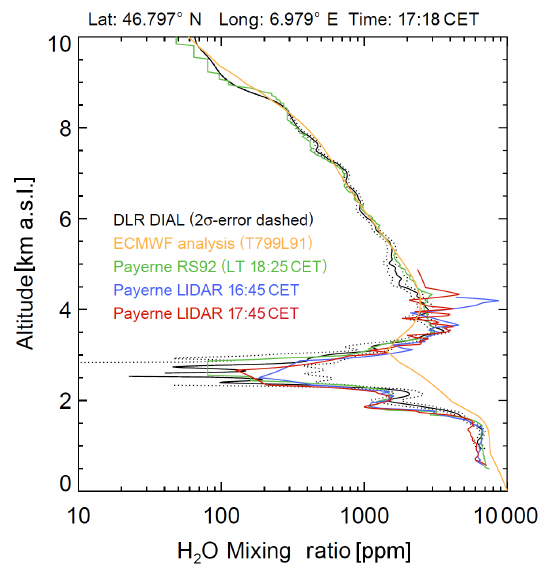
Figure A1. Comparison of the water-vapour mixing ratio from the Raman and the airborne lidar, and from a sonde ascent at Payerne; in addition, the corresponding humidity result from an ECMWF anal- ysis is given, which barely shows the intrusion layer. The times for the lidar systems (DLR: top of panel) refer to the middle of a mea- surement, for the sonde the launch time (LT) was